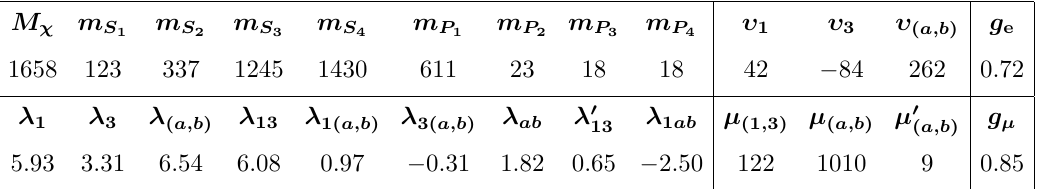
Table 2 . Example of a benchmark point. The spectrum mass parameters are given in GeV.